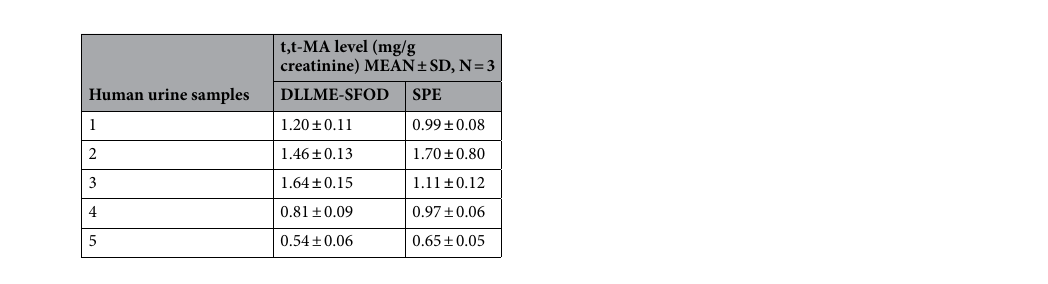
Table 4. Analysis of urine samples taken from workers of a petrochemical industry using two different extraction technique: DLLME-SFOD and SPE.